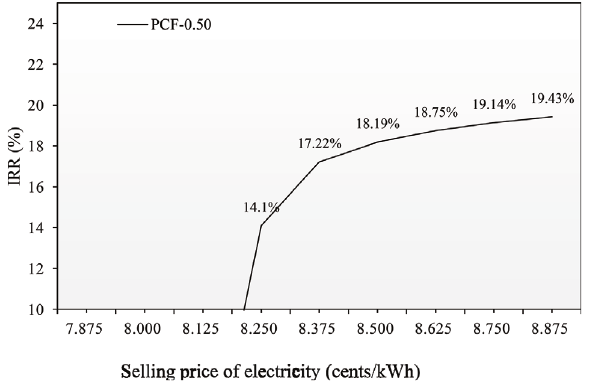
Figure 8. Variation of IRR with selling price of electricity (cents/kWh) considering high plant O&M costs-14.5$/MWh and fuel costs-11.2$/MWh, discount rate-10% and PCF-50%.